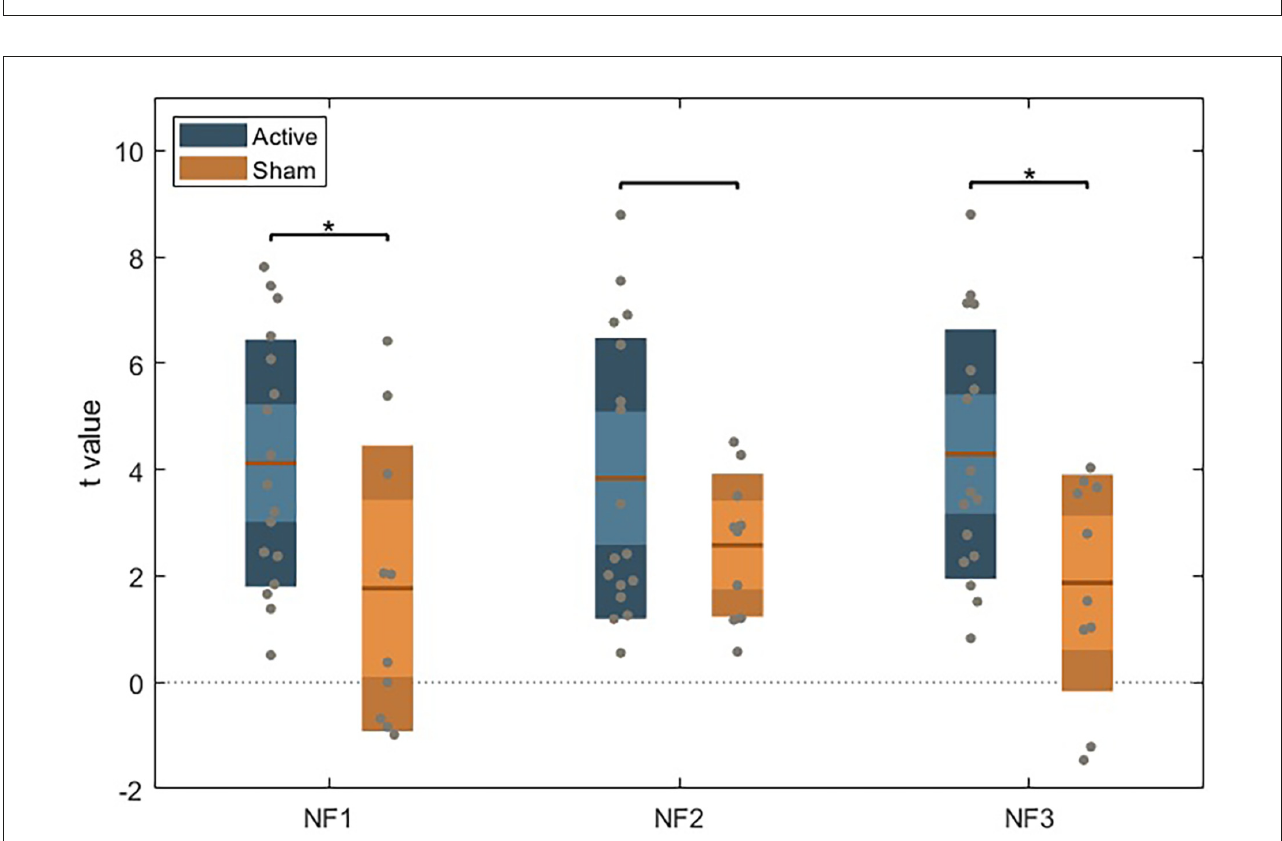
FIGURE3 Unpaired t -test between the active and sham group for each NF run, using Bonferroni’s correction. Dark color areas represent one standard deviation; light color areas represent the 95% confidence interval for the mean. Gray dots represent data for each subject. The brown line is the mean for each